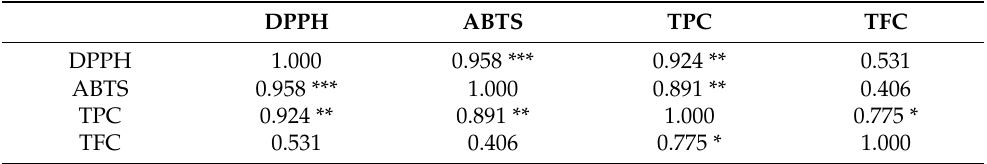
Table 2. Pearson’s correlation coefficient of TPC and TFC with antioxidant activity in the 60% methanolic extract of A. angustiloba